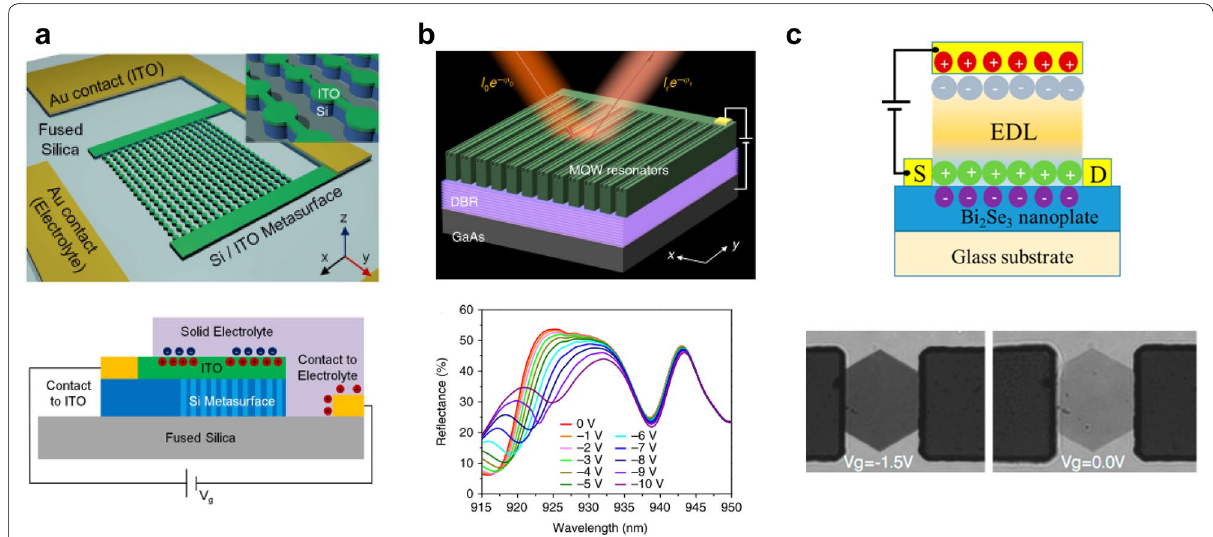
Fig. 2 Semiconducting material based tunable metasurfaces. a ITO‑Si nanoantenna heterojunction for tunable metasurface. Si nanoantennas support optical resonance and electrical bias simultaneously [58]. Reproduced with permission from ©2018, Optical Society of America. b GaAs‑based semiconductor heterostructure for tunable quantum‑confined Stark effect [50]. Reproduced with permission from ©2019, Springer Nature. c